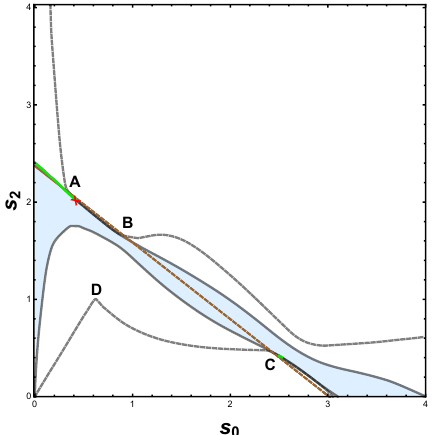
Figure 8: Experimental “Peninsula” inside the river (indicated by grey dashed